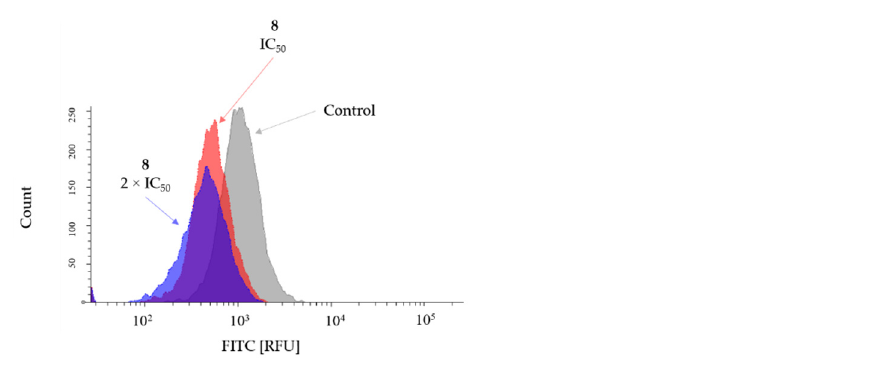
Figure 7. The impact of compound 8 on ROS produced by PC3. 8 was tested using IC 50 , 2 × IC 50 concentrations for 48 h using DHR assay, fluorescence was detected in FITC channel (ex/em: 488/520 nm).